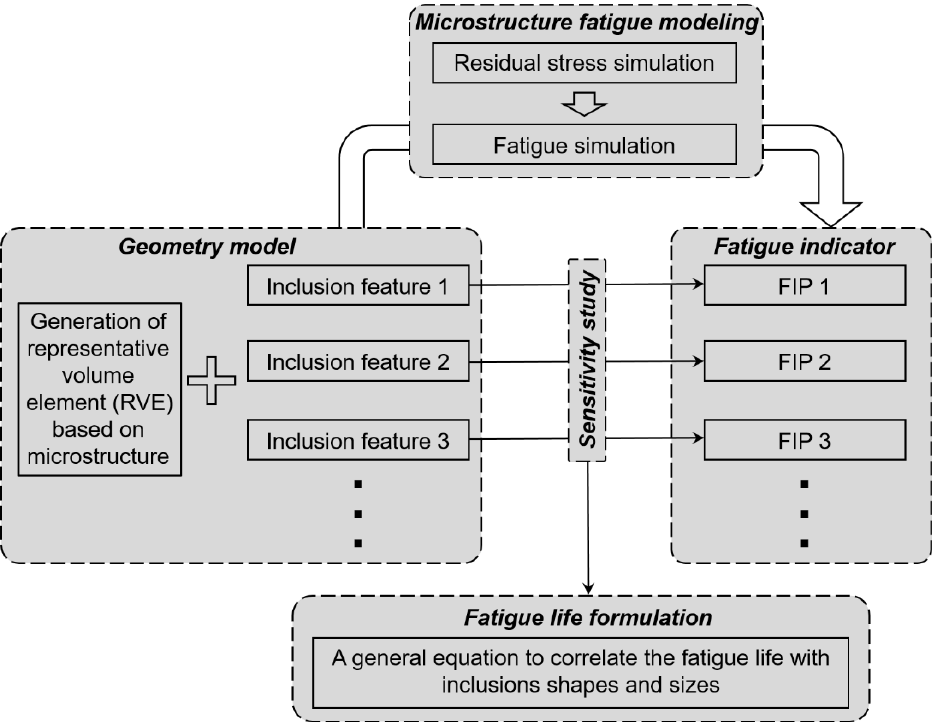
Figure 1. The flow chart of the investigation strategy in this study.